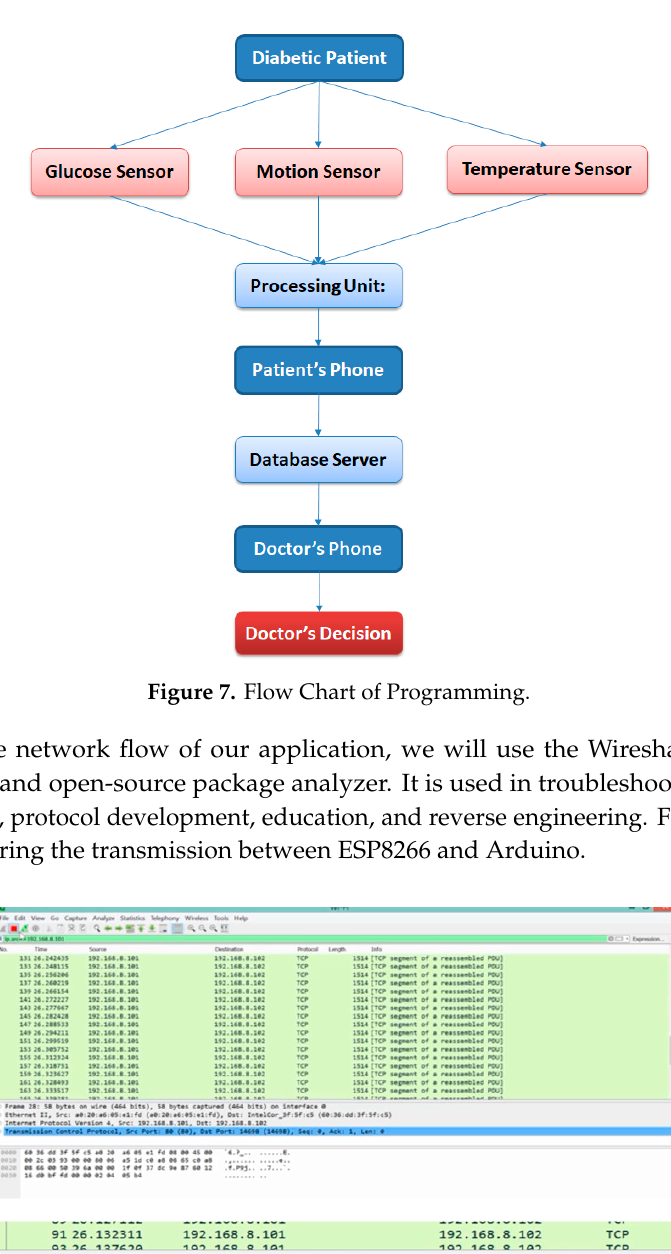
Figure 8. The packet captured during transmission between ESP8266 and Arduino.